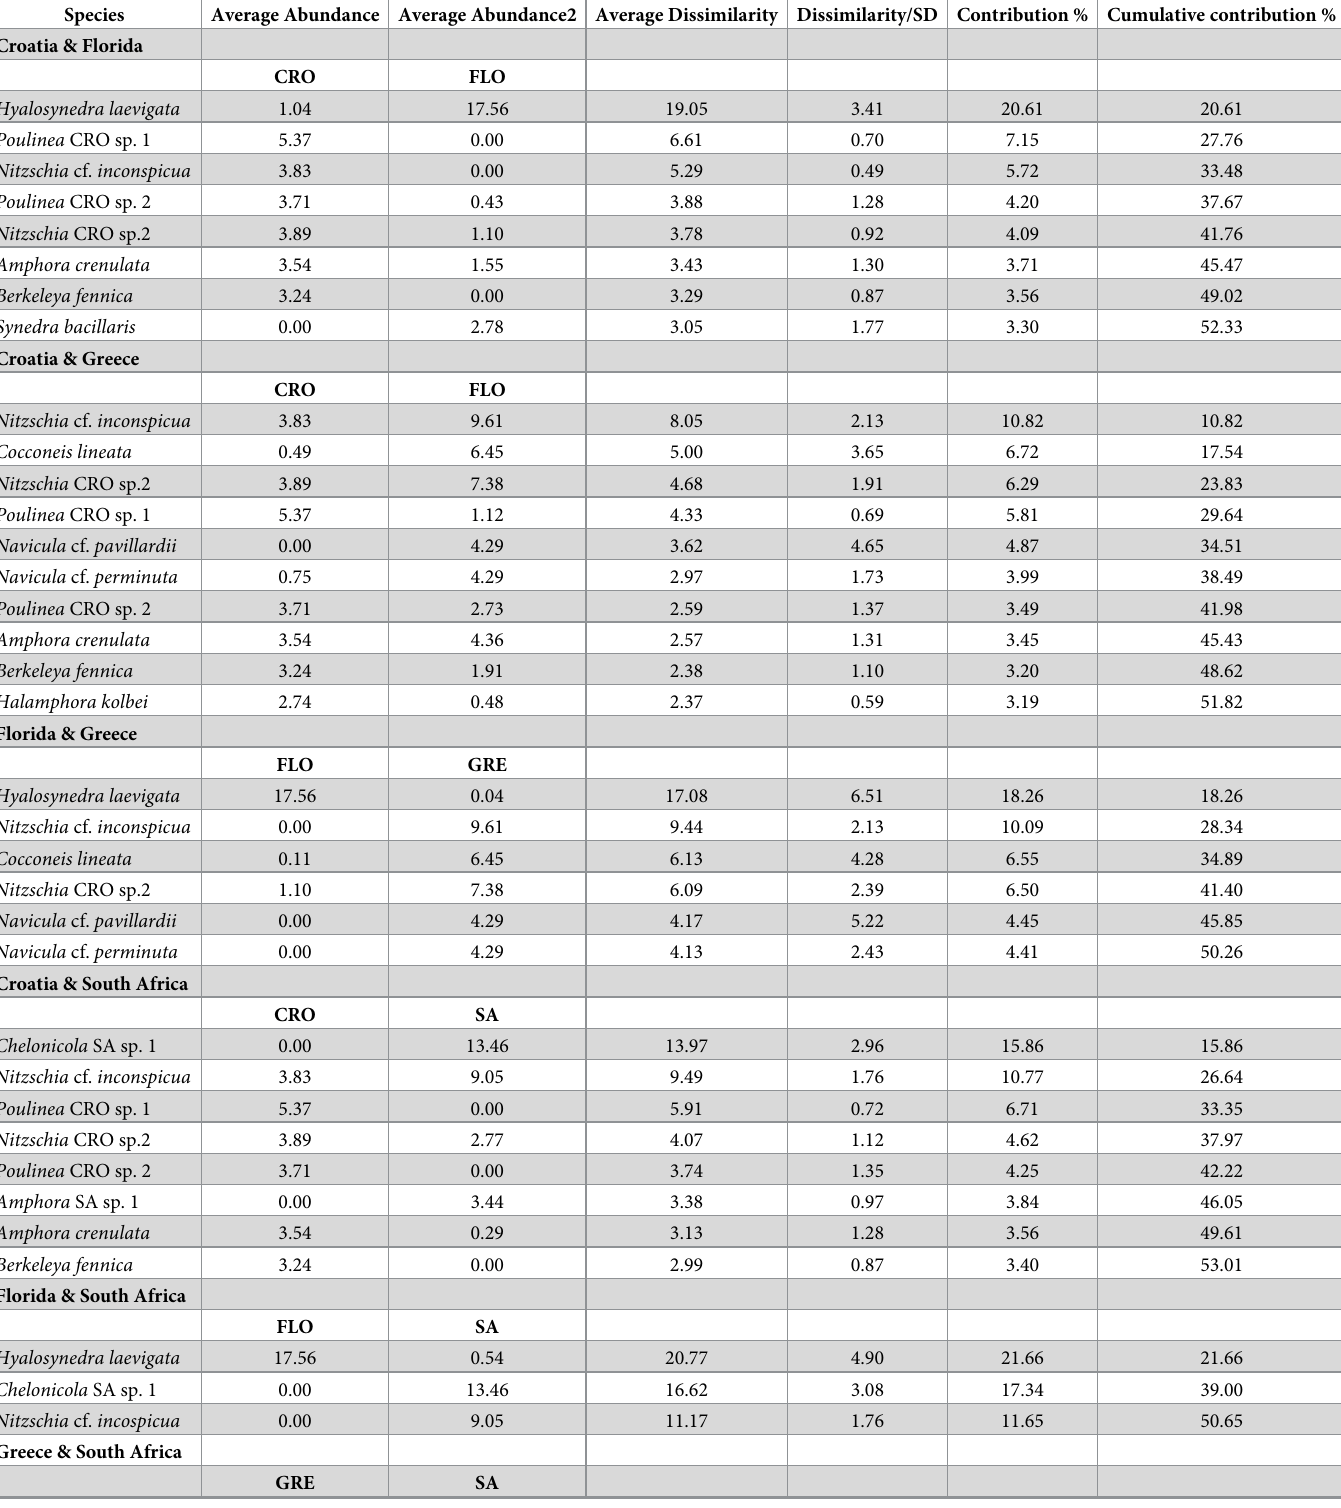
Table 4. Contribution of species to dissimilarities between epizoic diatom assemblages of loggerhead populations–discriminating species.